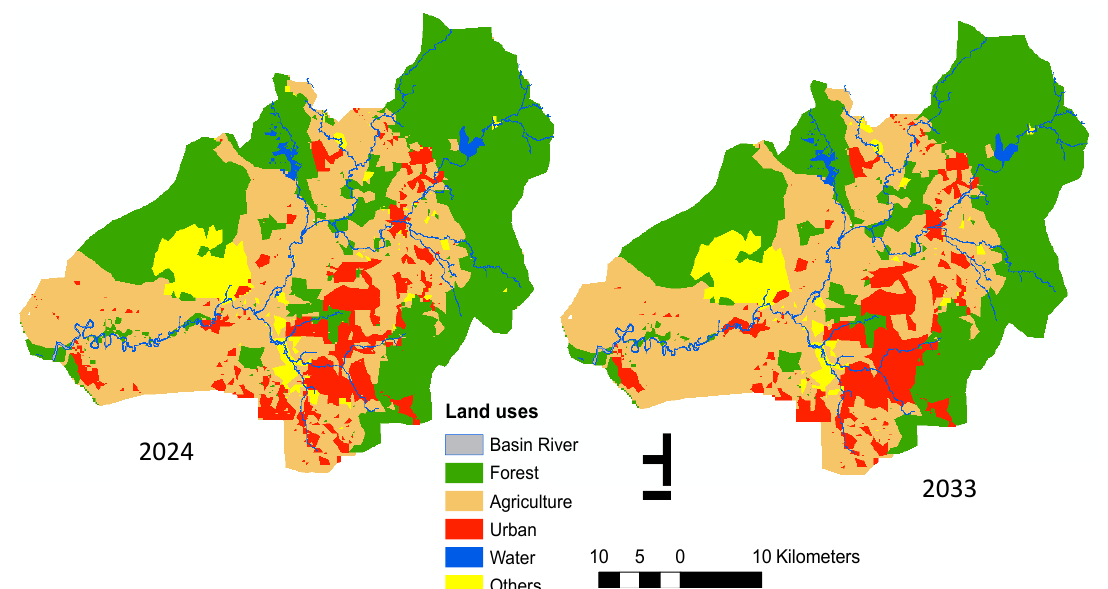
Fig. 6: The future simulated changes in land use of the Selangor River basin in 2024 and 2033